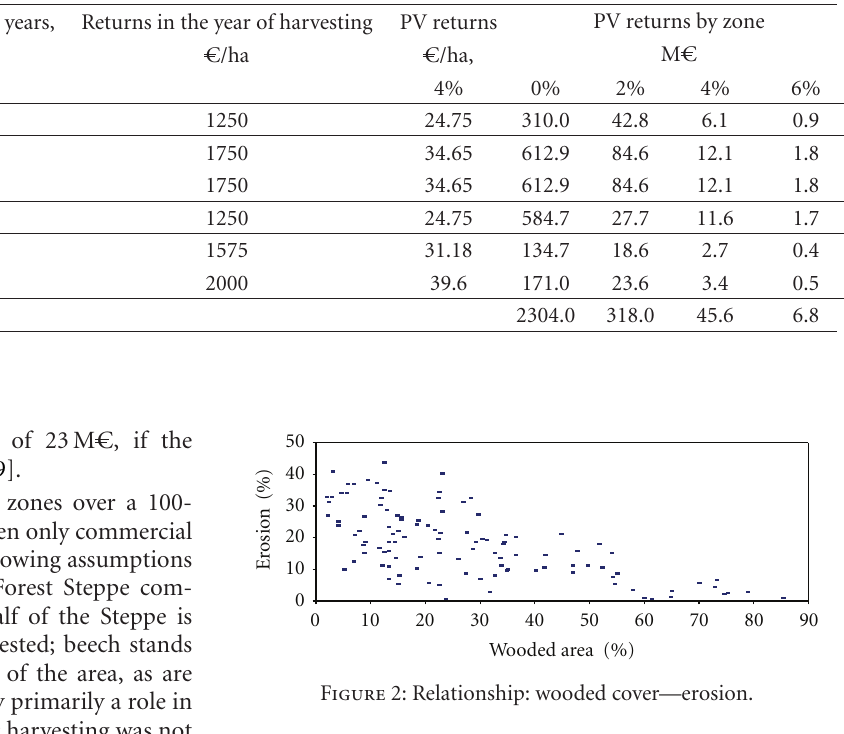
Table 4: Estimates of the returns from timber harvesting.